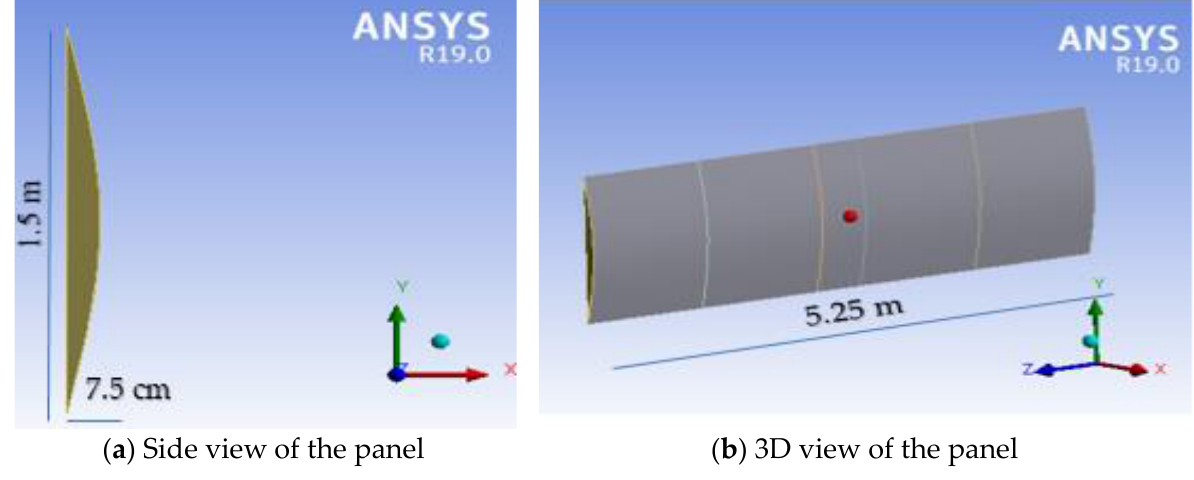
Figure 16. Mitigation panel.